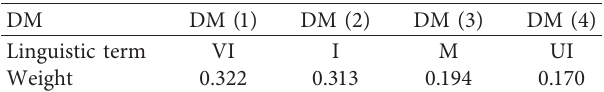
Table 15: The importance of decision-makers and their